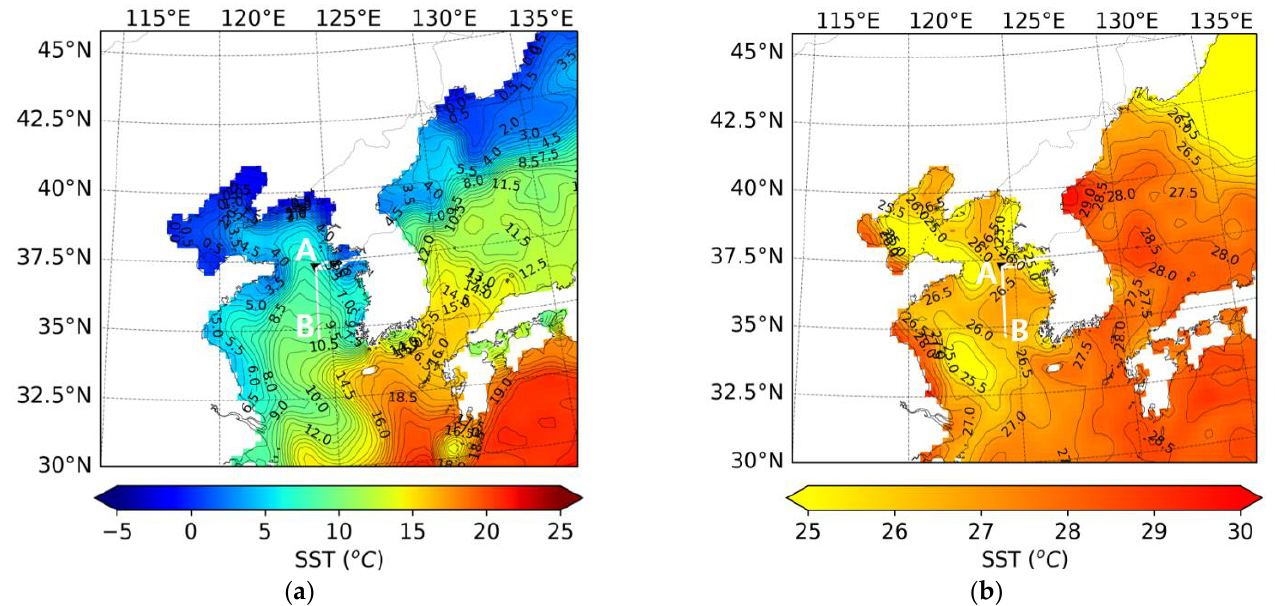
Figure 3. SST field and aircraft trajectories on ( a ) 3 February 2021, and ( b ) 2 August 2021. Each black triangle represents the point at which the dropsonde was launched from the NARA at an altitude of approximately 4 km in the WS. The solid white line represents the flight path of the aircraft.